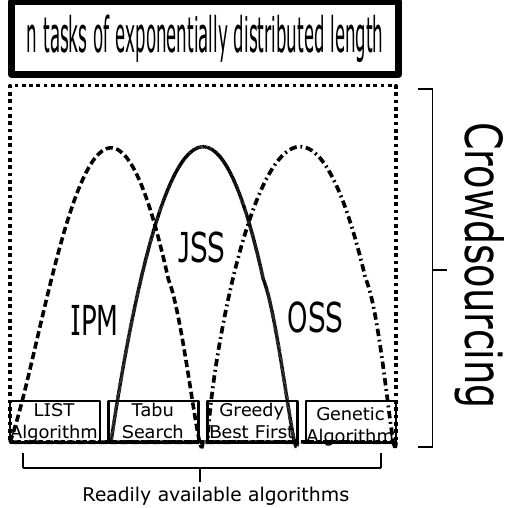
Figure 3. Experimental setup for evaluating all the variants of the scheduling problem, namely: Identical Parallel Machines (IPM), Job Shop Scheduling (JSS) and Open Shop Scheduling